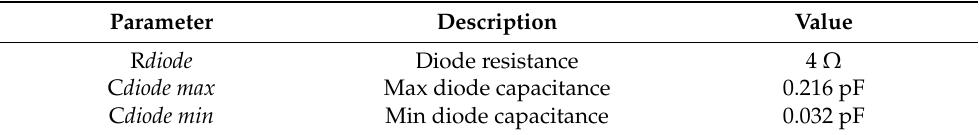
Table 2. Electrical unit cell